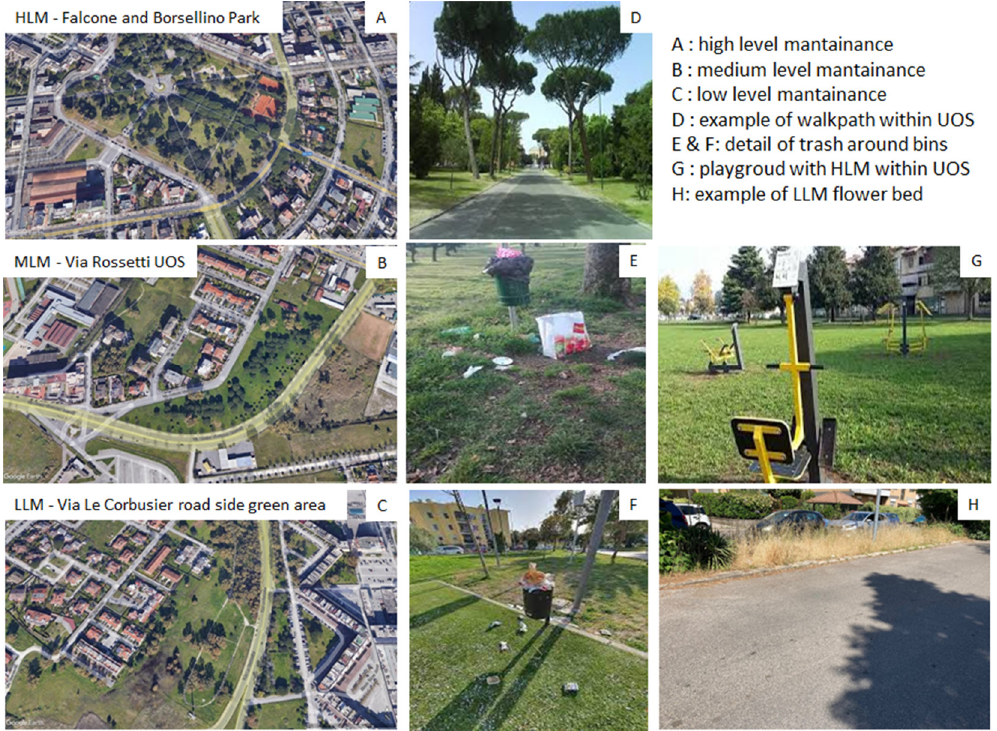
Figure 10. UOS with high, medium and low levels of maintenance (HLM, MLM, LLM). Other details of waste bins, playgrounds, monumental trees, and flower beds are reported (Source: own photos).